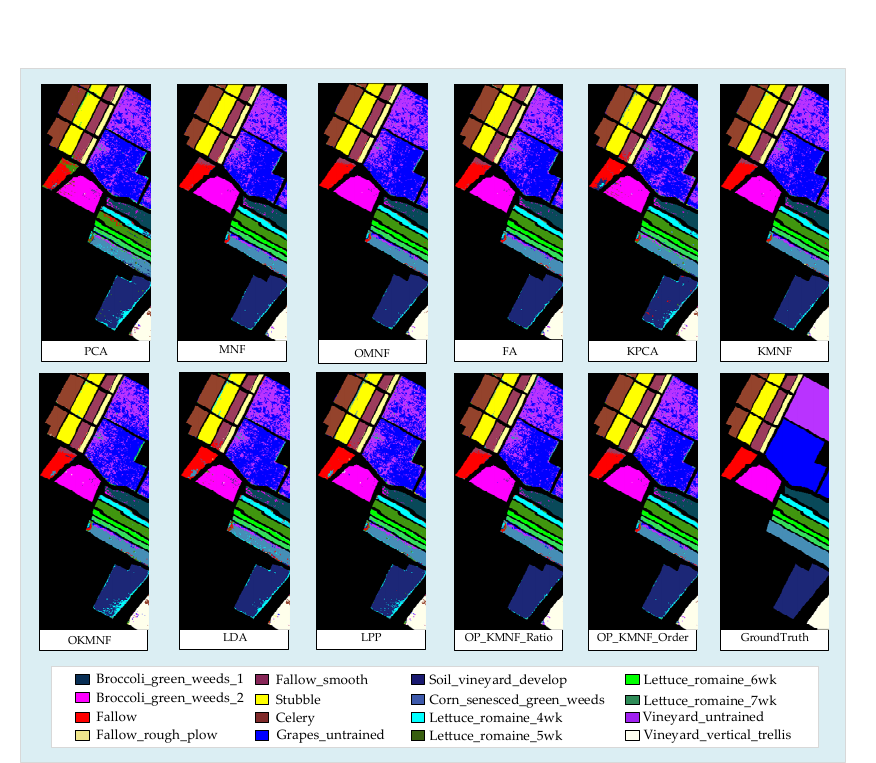
Figure 8. The SVM classification results of Salinas after different DR methods (number of features = 5).